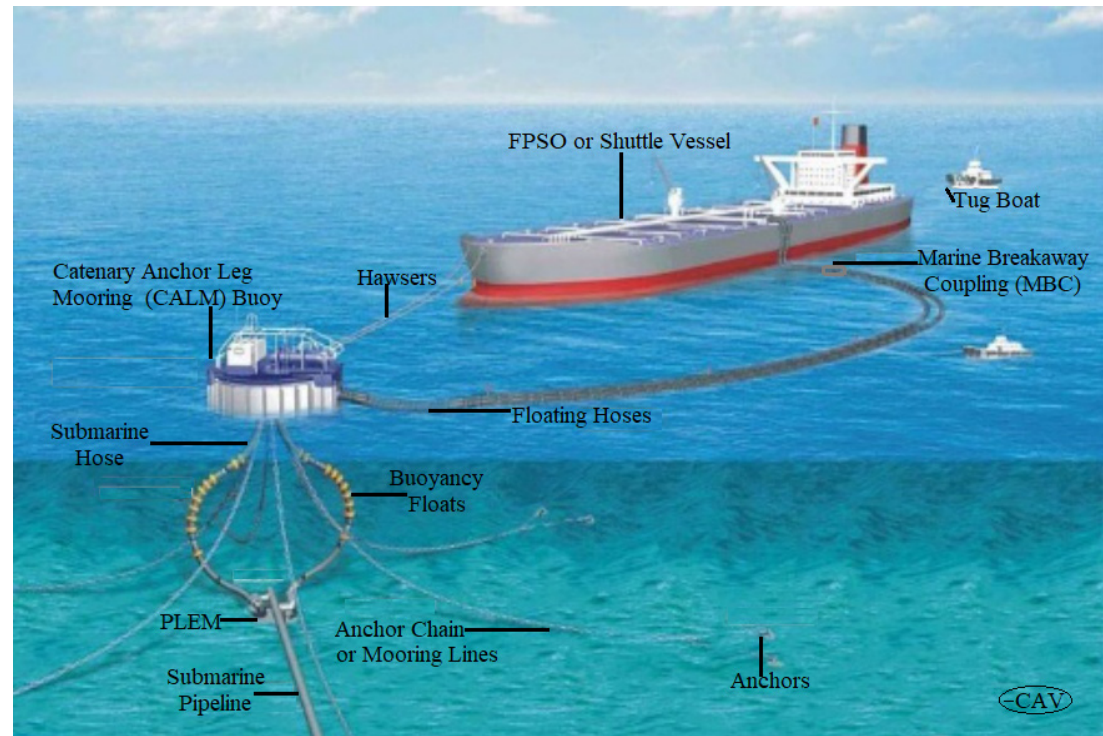
Figure 7 . Catenary Anchor Leg Mooring (CALM) Buoy hose system depicting Chinese-Lantern configuration and single point mooring (SPM).